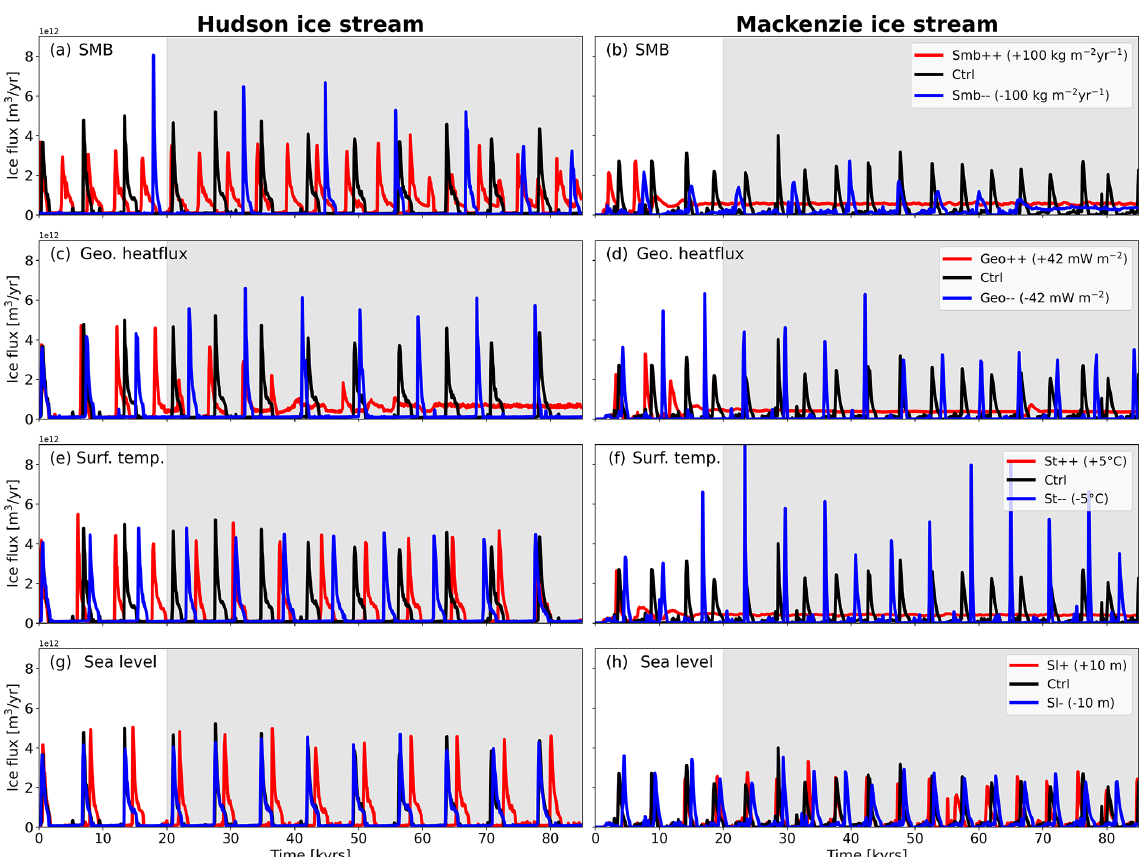
Figure 7. Similar to Fig. 3 but for Hudson (left) and Mackenzie (right) ice stream separately. The panels show the response to (a, b) SMB, (c, d) geothermal heat flux, (e, f) ice surface temperature, and (g, h) sea-level perturbations. Grey shading highlights the analysis